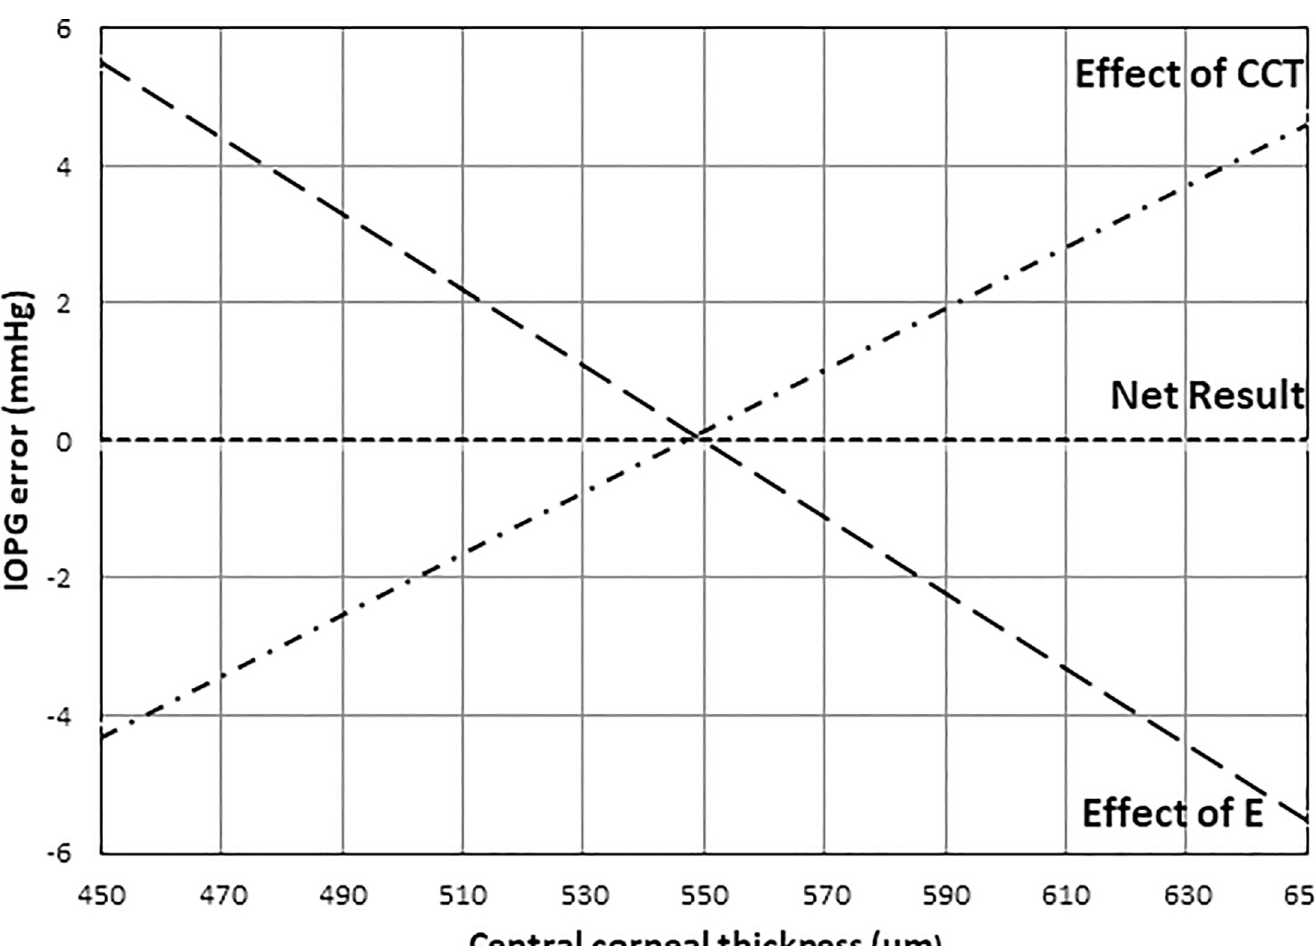
Fig 6. Figure demonstrates the actual Goldmann tonometry error obtained in this subject group (Net Result), the Goldmann tonometry error calculated from E iopg (Effect of E) and from the error due to central corneal thickness as calculated from the Orssengo and Pye (Effect of